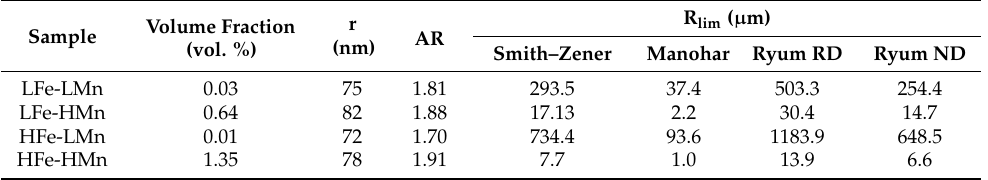
Table A2. Volume fractions and morphological parameters of the dispersoids for S-C cast samples homogenized at 550 ◦ C, cold rolled to a CRD of 35% and soft annealed; limiting grain sizes calculated using the models of Smith–Zener [26], Manohar [33] and Ryum [32].